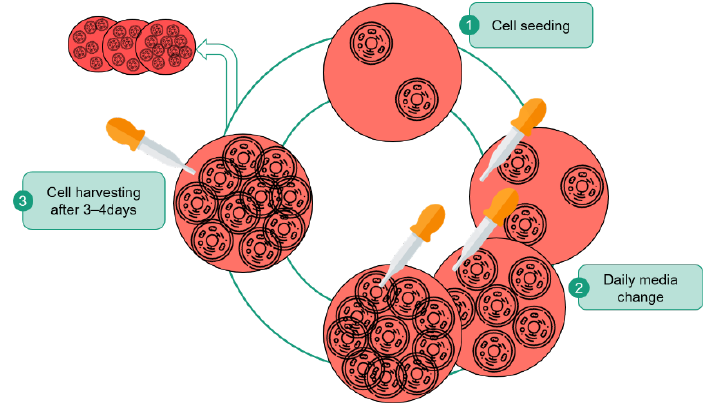
Figure 1. Expansion of stem cells .